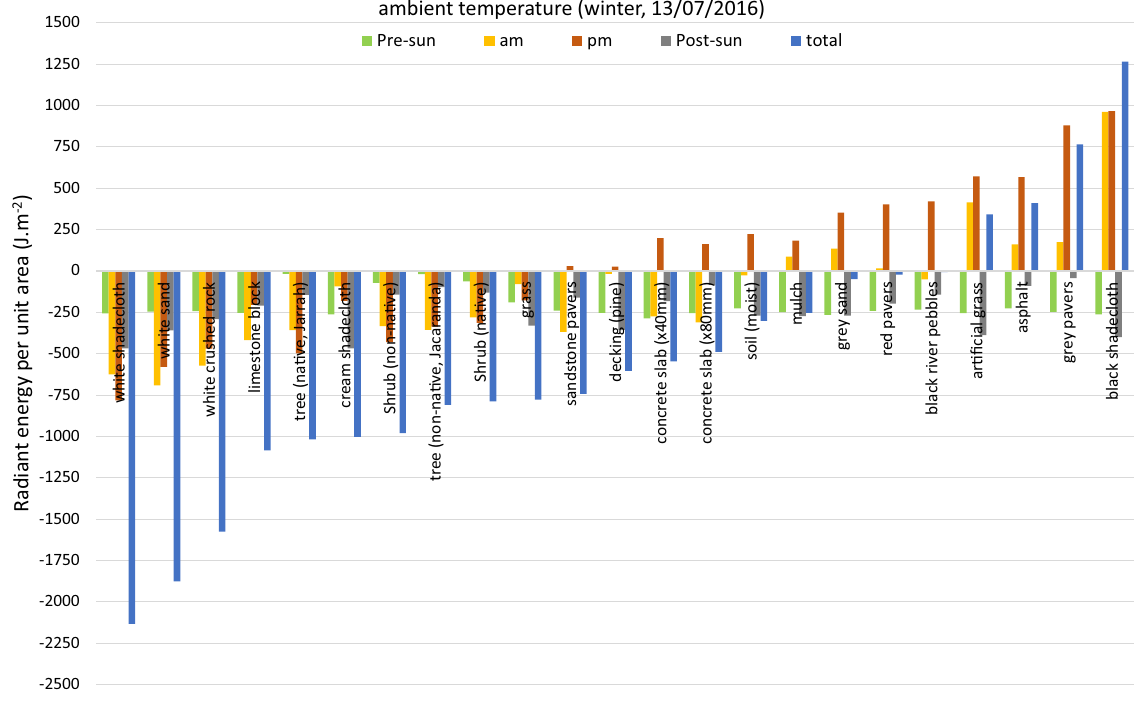
Fig. 2. Graph of fi nal radiant energy per unit area (J m (cid:1) 2 ) for each LE in winter (13/07/2016).